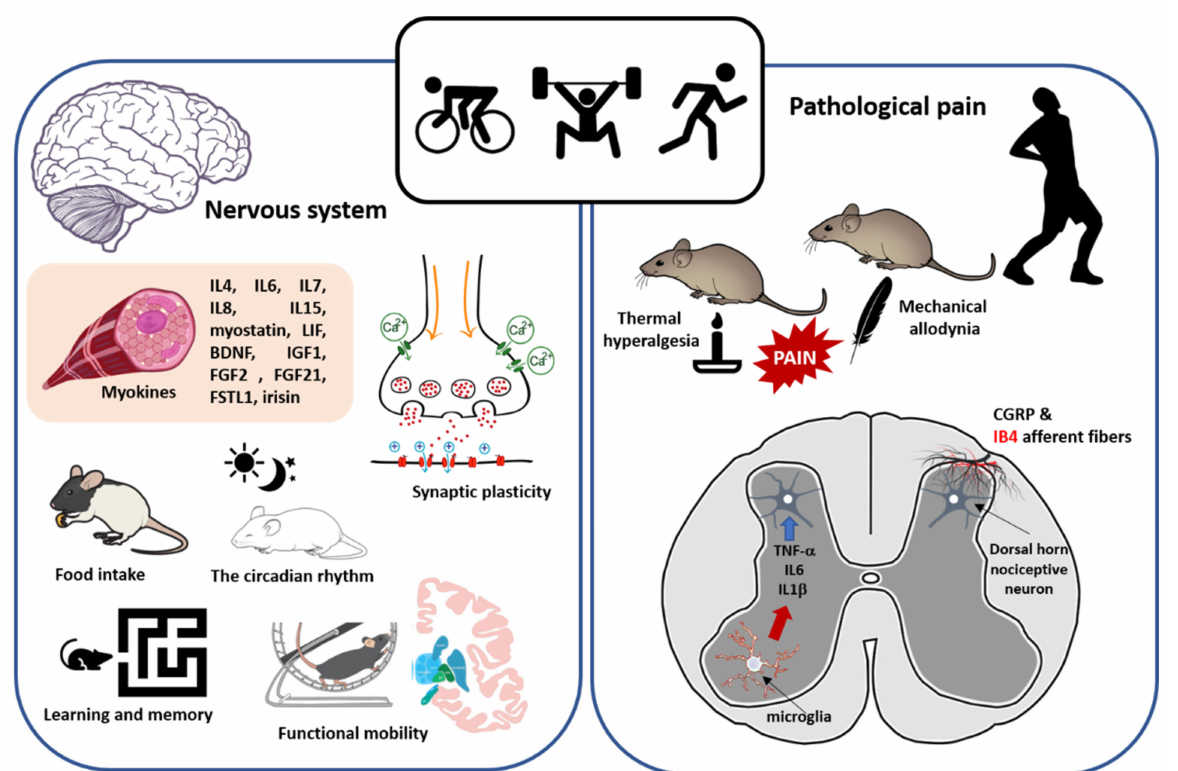
Figure 4. Effects of physical exercise on the nervous system and pathological pain. Various functions of the nervous system are also affected by physical exercise. Thus, physical exercise enhances synaptic plasticity, regulates food intake, modulates circadian rhythm, enhances learning and memory processes, and modifies neural circuits (e.g., basal ganglia) that improve the functional mobility of subjects. It should be noted that with physical exercise, the continued contraction of skeletal muscle fibers produces a significant release of myokines by this tissue. These myokines, together with other diffusible factors secreted by glial and vascular elements of the nervous system, are responsible for the changes described with physical exercise. On the other hand, physical exercise also has an impact on pathological pain. In animal models, physical exercise has been shown to reduce thermal hyperalgesia and mechanical allodynia. This analgesic effect of physical exercise is mediated by less activation of glial cells (e.g., microglia), which secrete fewer inflammatory cytokines, and with this there is less sensitization and excitation of the nociceptive neurons of the dorsal horn of the spinal cord, but also from nociceptive neurons from other supraspinal pain processing centers. At the spinal level, physical exercise also produces less branching of nociceptive peptidergic (CGRP-positive) and non-peptidergic (IB4-positive) afferent fibers in the dorsal horn of the spinal cord; therefore, there is less input of pain. For details, see the main text. Source for figure illustrations: https://scidraw.io/ (accessed on 8 September